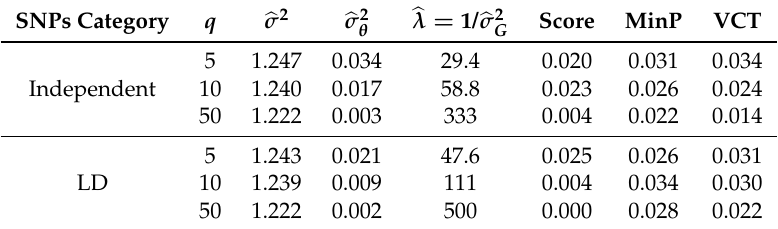
Table 1. Type I error at 0.05 α -level for each method depending on the number of SNPs q and whether the SNPs are independent or in LD. Two of the SNPs in each scenario have a main